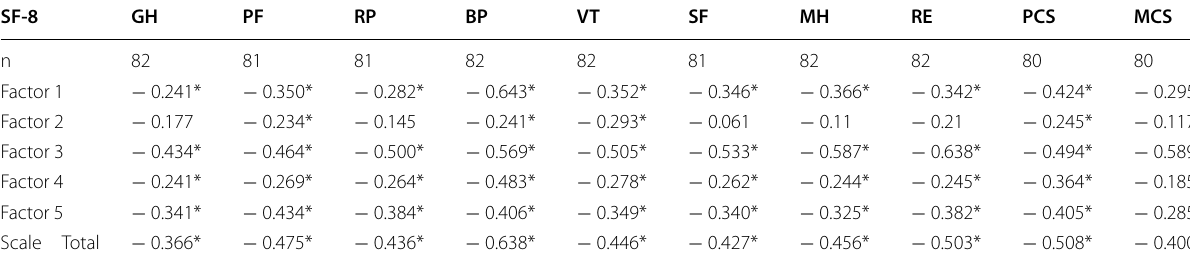
Table 5 Spearman’s correlation between the AFQOL and